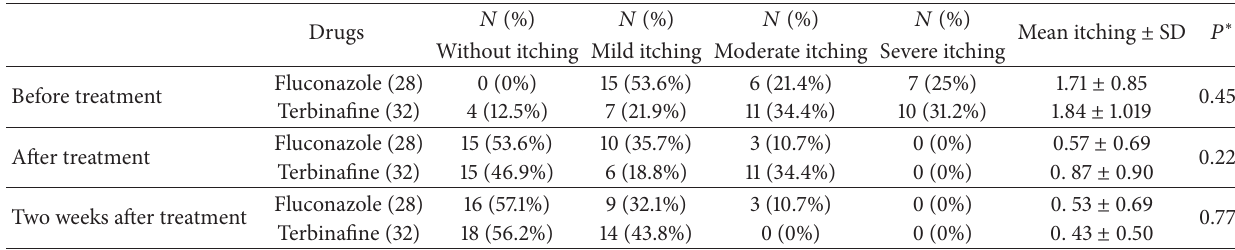
Table 4: Comparison of itching in three-phase study.